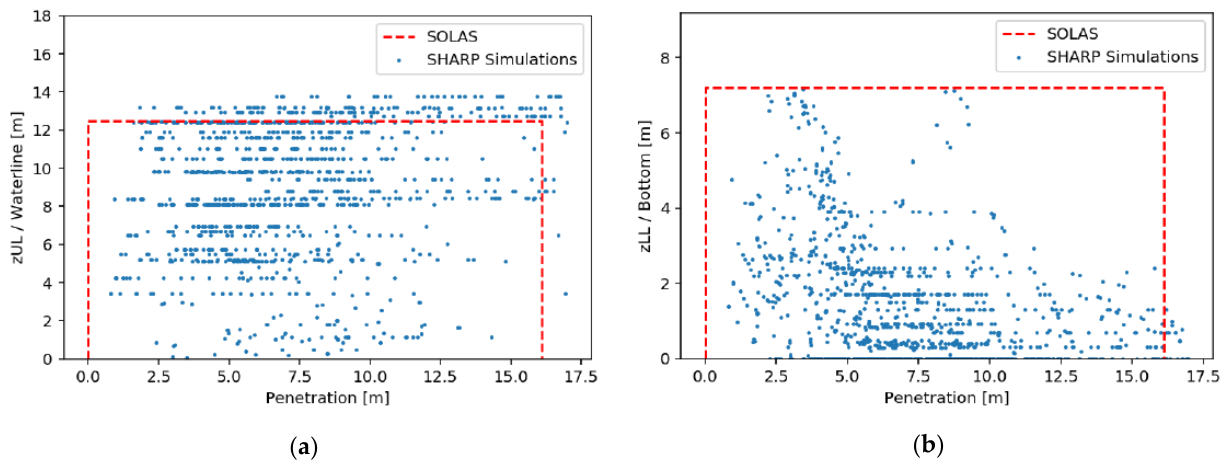
Figure 22. Damage vertical positions versus damage length for simulated damages: ( a ) upper limit; ( b ) lower limit.